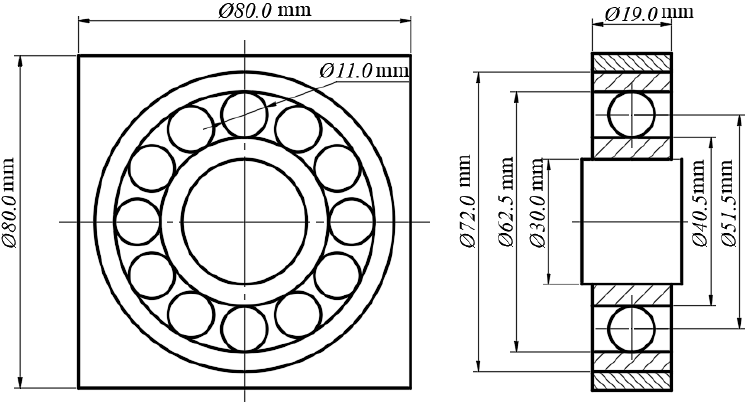
Figure 4. The geometric dimensions of an NU306 bearing. Table 1. The material parameters of NU306 bearing.